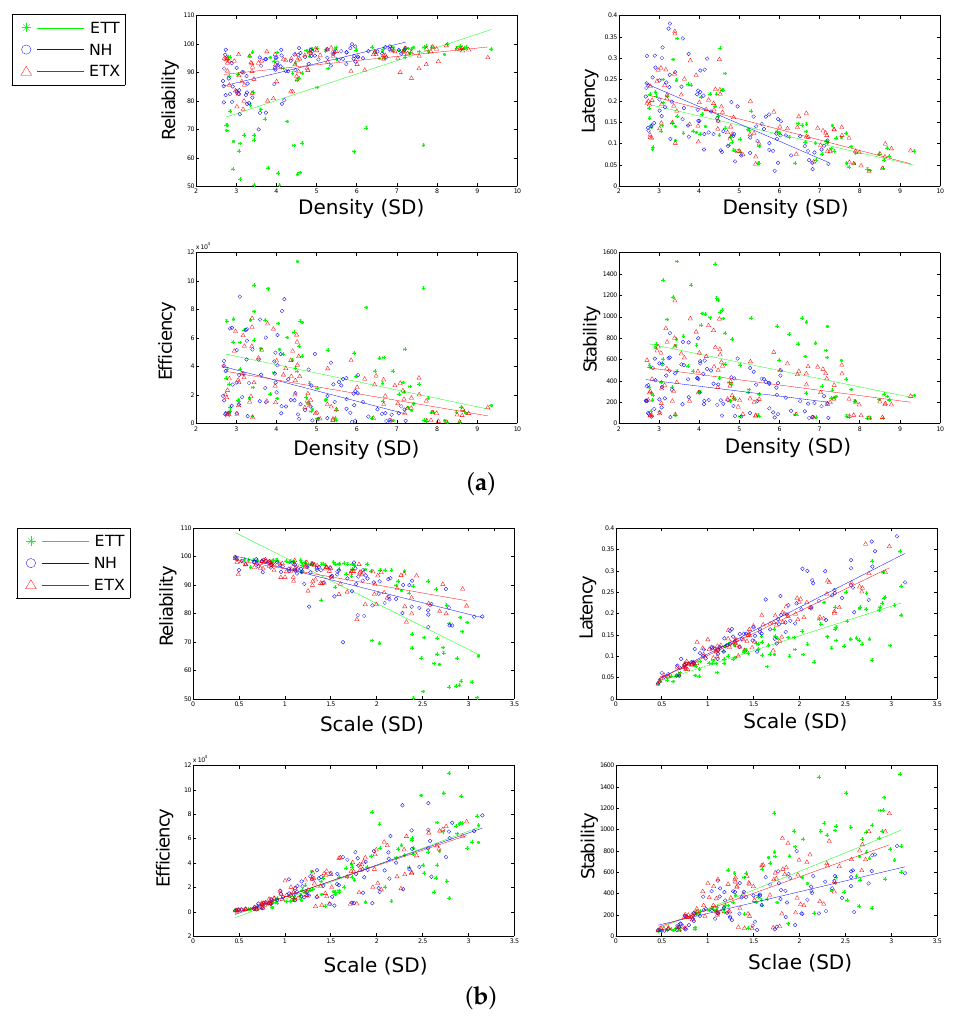
Figure 14. Results from simulation with regard to the secondary features. ( a ) Solution performance with regard to standard deviation of density; ( b ) Solution performance with regard to standard deviation of